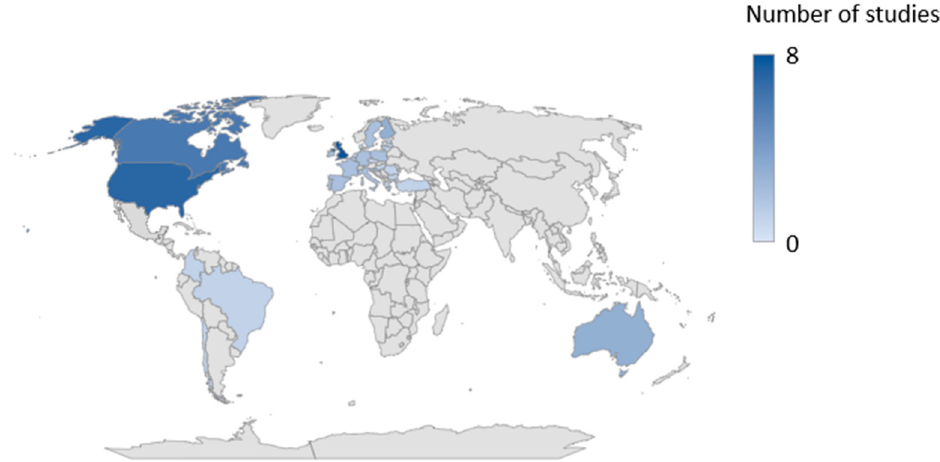
Figure 3. Geographical distribution of digital maturity examined in the included studies.